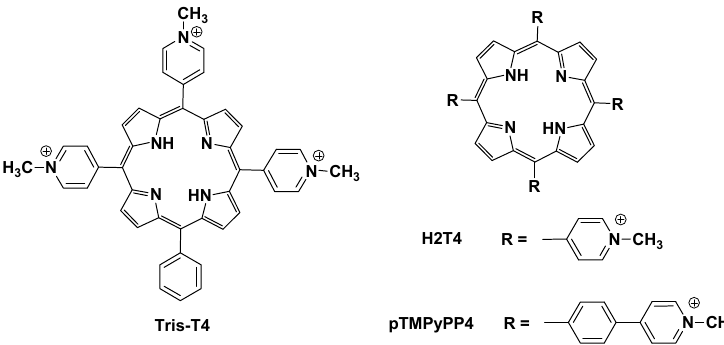
Figure 2. Chemical structure of porphyrins H2T4, Tris ‐ T4 and pTMPyPP4.